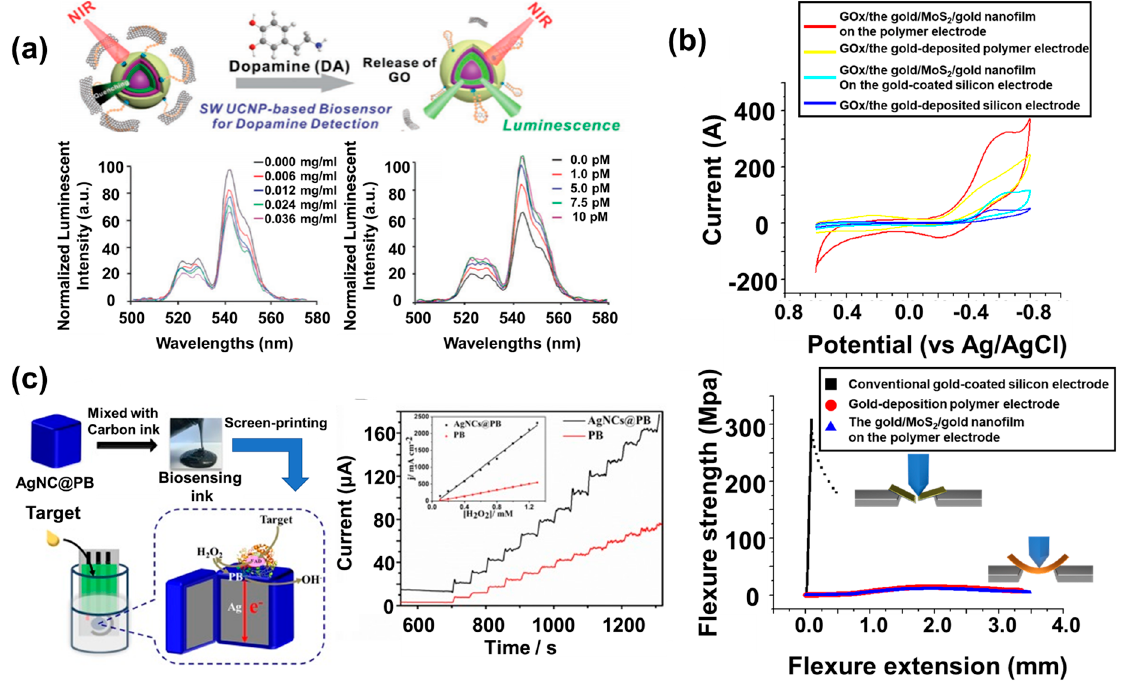
Figure 5. Biosensors based on hybrid NPs. ( a ) A dopamine biosensor composed of graphene oxide (GO)-encapsulated sandwich-structured UCNPs, and its sensitive dopamine detection